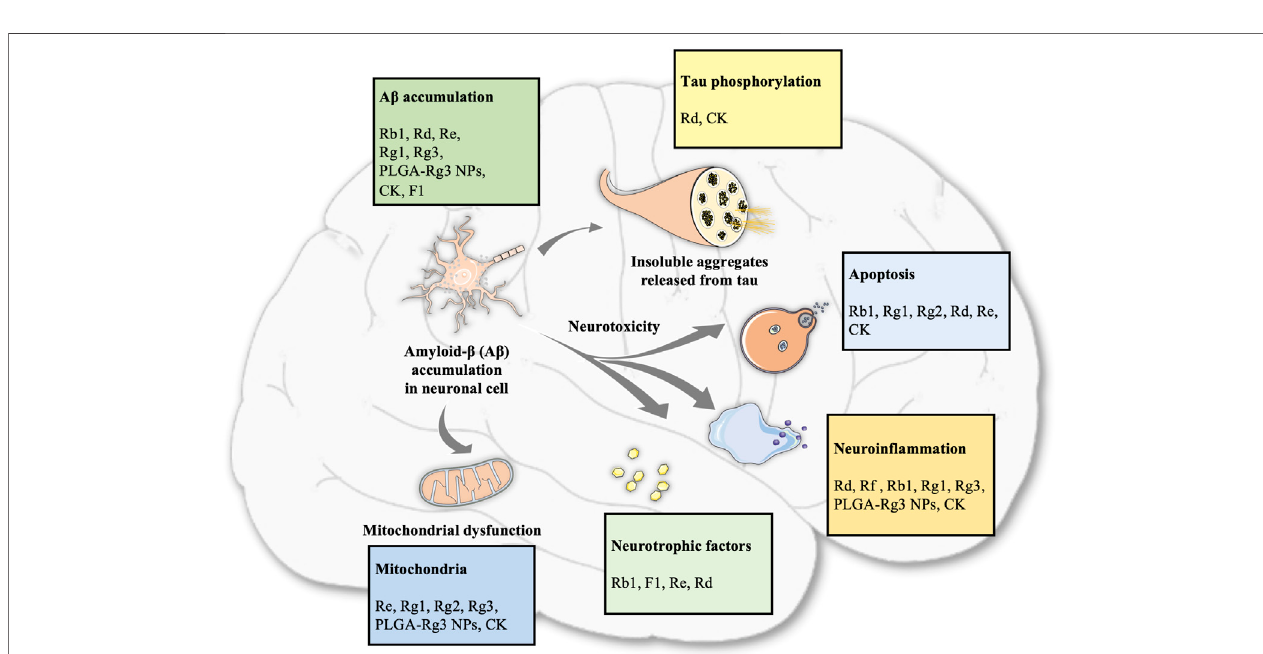
FIGURE 1 | Summary of different ginsenoside monomers involved in various pathological processes of AD.